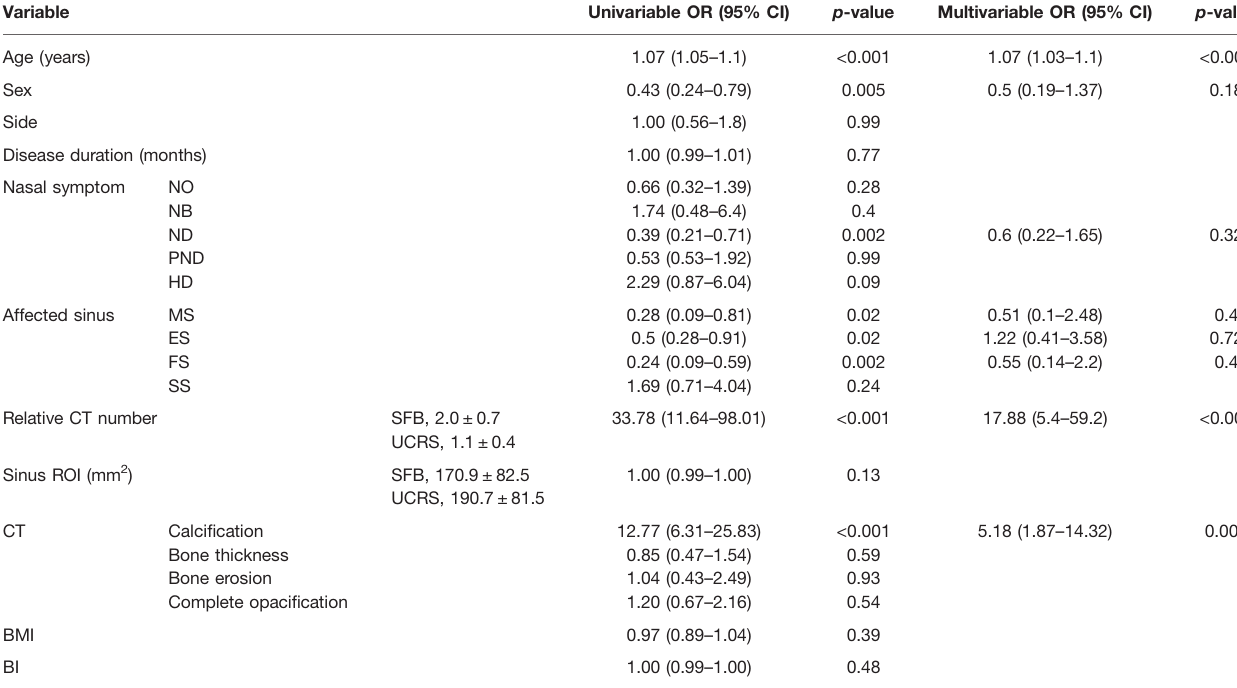
TABLE 3 | Univariable and multivariable analyses of factors predictive of SFB (SFB, 86 cases; UCRS, 97 cases; N